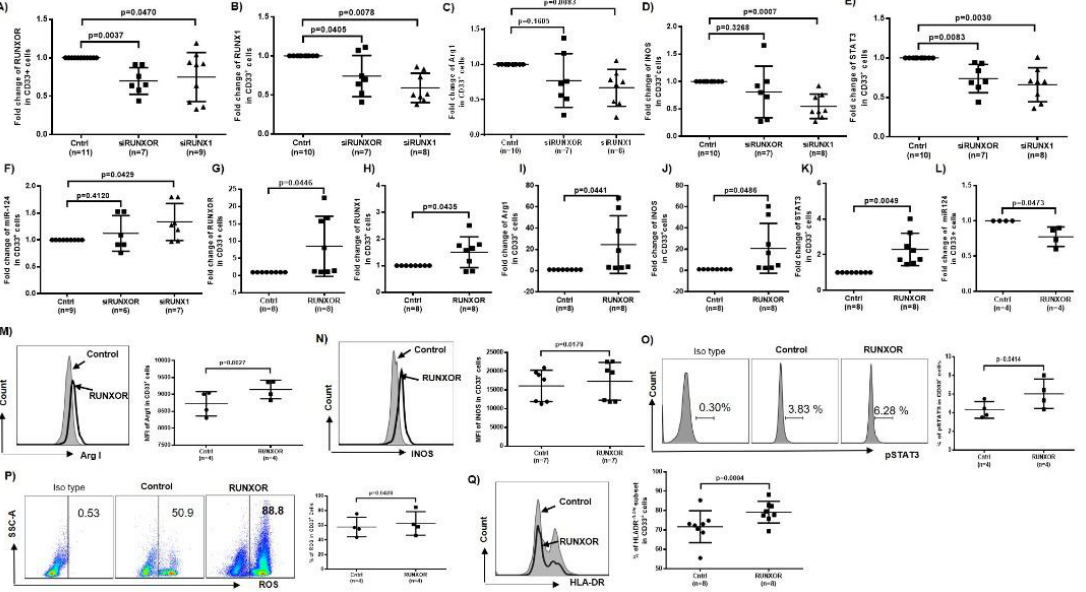
Figure 3. Silencing or Ectopic expression of RUNXOR or RUNX1 in CD33 + cells affects MDSC differentiation and immunosuppressive functions. ( A , B ) RUNXOR or RUNX1 expressions in HCV-CD33 + cells transfected by control, RUNXOR, or RUNX1 siRNA, determined by real-time RT-qPCR. ( C – F ) Arg1, iNOS, STAT3, and miR-124 expressions in HCV-CD33 + cells transfected with control, RUNXOR, or RUNX1 siRNA, determined by real-time RT-qPCR. ( G – L ) Ectopic expression of RUNXOR promotes RUNXOR, RUNX1, Arg1, iNOS, and STAT3 mRNA expressions and reduces miR-124 levels in CD33 + myeloid cells. ( M – Q ) Overexpression of RUNXOR in healthy CD33 + cells enhances Arg1, iNOS, and pSTAT3 protein expressions, increases ROS productions, and promotes immature myeloid cells (HLA-DR −/low CD33 + ) differentiation into MDSCs, as determined by flow cytometry analysis.